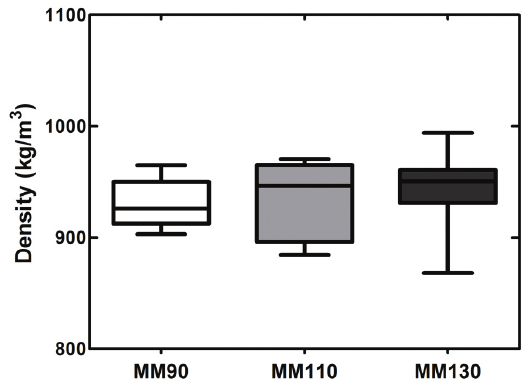
Figure 1. Average density of the Tauari